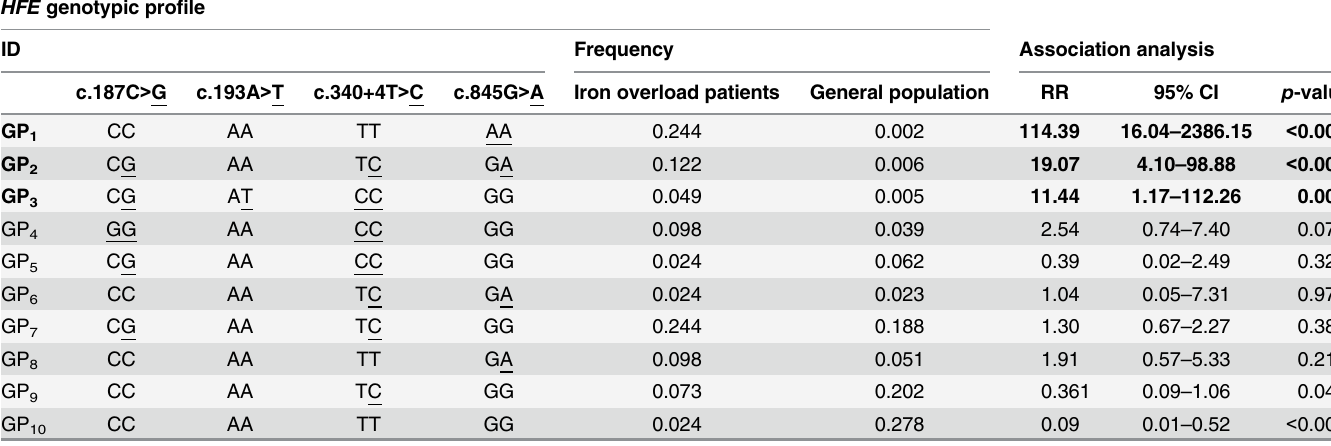
Table 3. HFE genotypic profile frequency and association analysis with iron